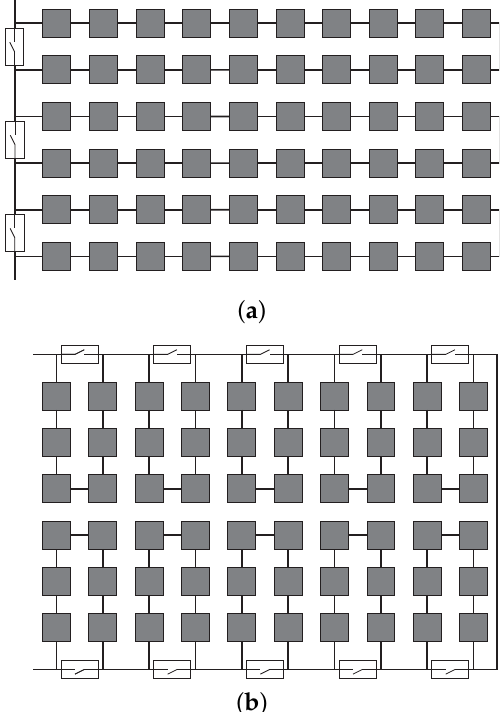
Figure 4. ( a ) The old panel setup , three substrings of 20 cells vs. ( b ) the new panel setup , 10 substrings of six cells with the location of the